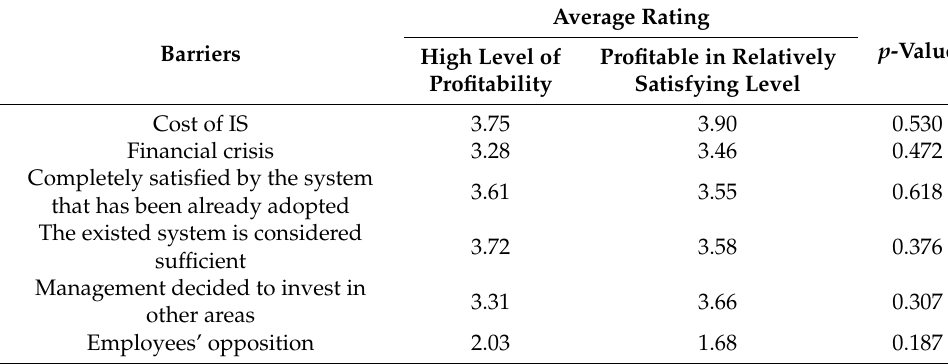
Table 5. Barriers of IS adoption—level of